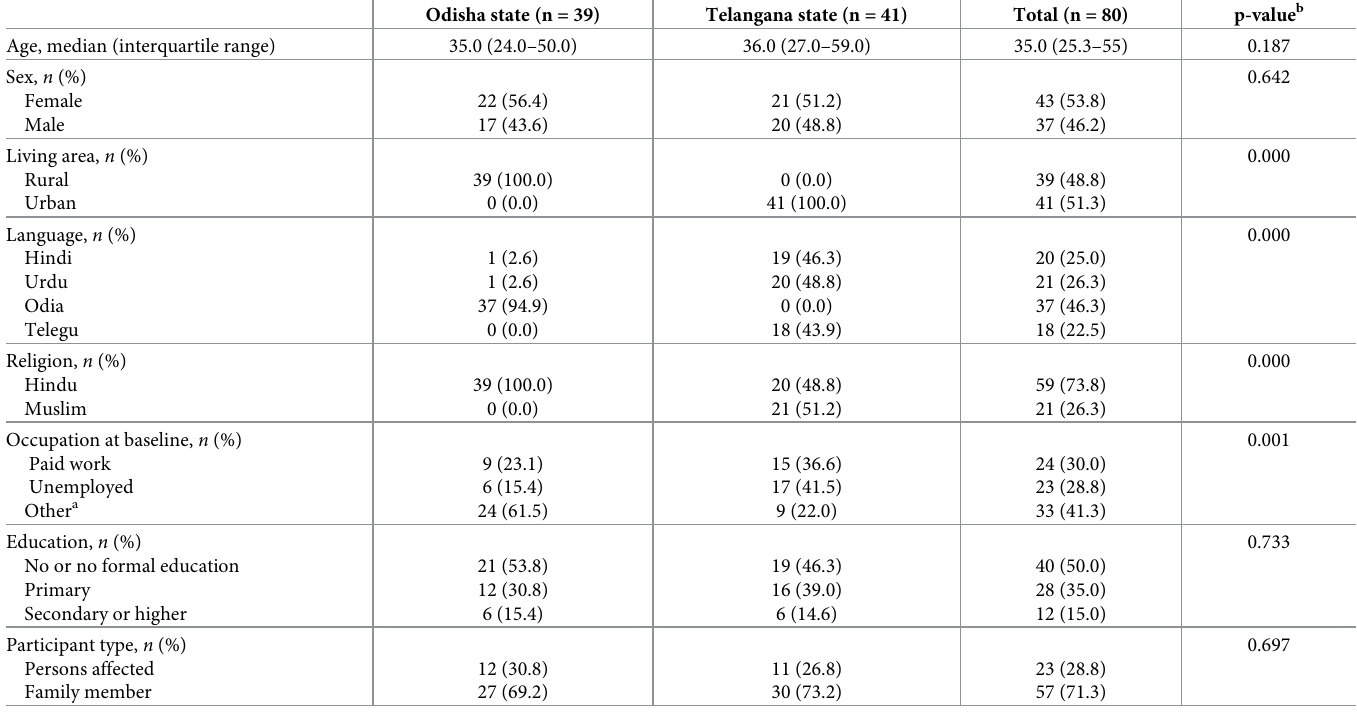
Table 1. Demographic information of the study